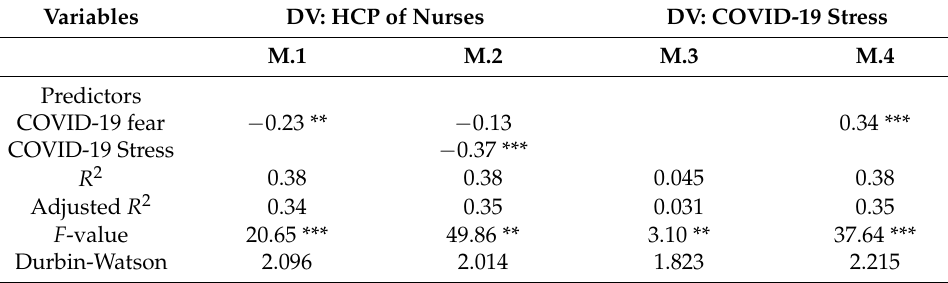
Table 3. Results for the mediating effects of